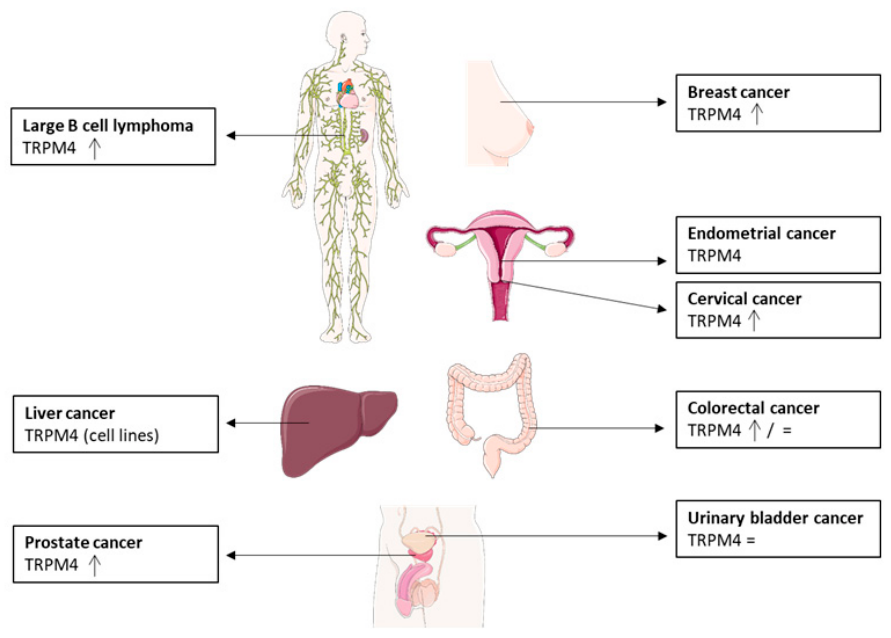
Figure 2. Summary of TRM4 expression levels in different cancer types compared to healthy control tissue (=: expression levels not changed, arrow: increased expression levels) [109].